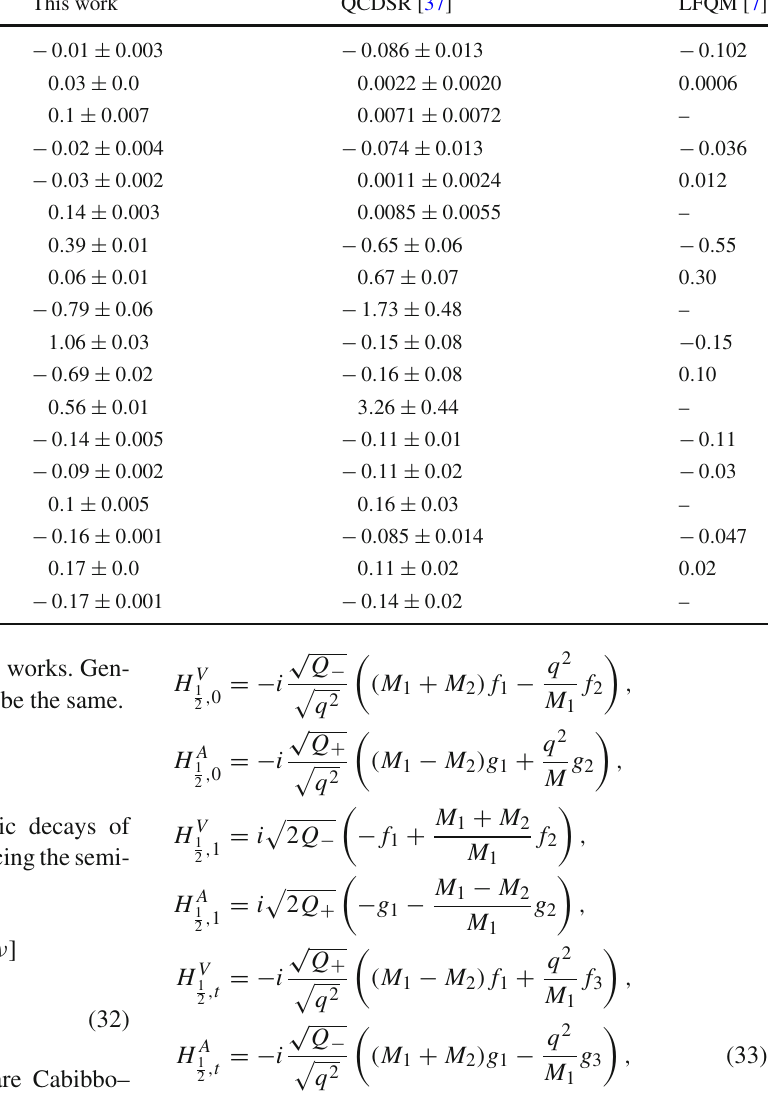
Table 5 Comparison of our results on (cid:3) bb and (cid:3) bc decay form factors with the results from QCD sum rules (QCDSR) [37] and light-front quark model (LFQM) [7] Transitions F ( 0 ) This work QCDSR [37] LFQM